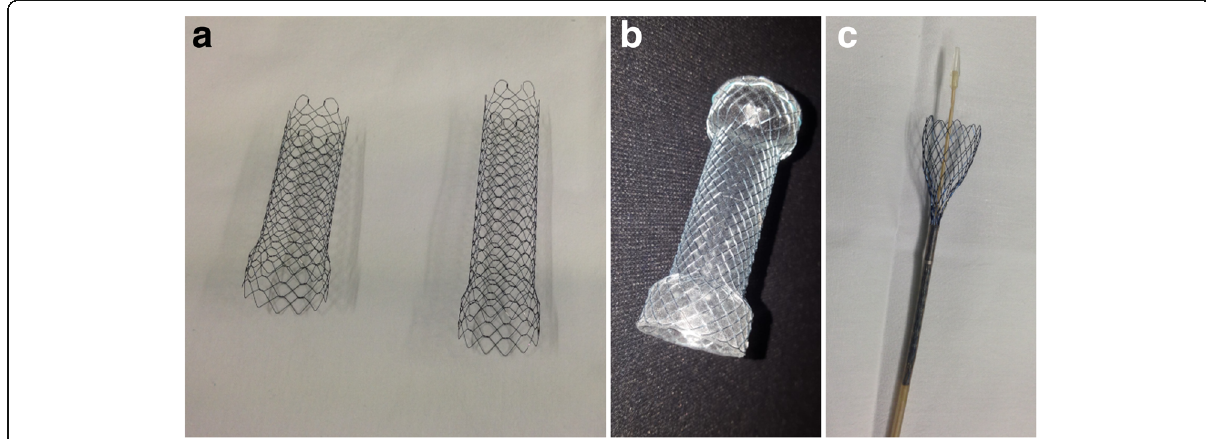
Fig. 1 Some common self-expandable metal stents (SEMS) available for use in colorectal disorders. a Two opened uncovered WallFlex TM (Boston Scientific, Massachusetts, USA) stents measuring 25 × 60 mm (left side) and 22 × 90 mm (right side), respectively. b Fully covered Niti-S